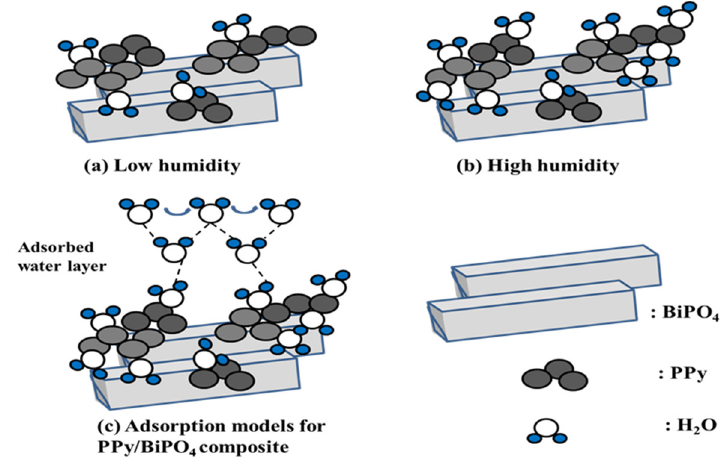
Figure 9. Scheme of humidity-sensing mechanism: ( a ) low humidity, ( b ) high humidity, ( c ) adsorption models for PPy/BiPO 4 composites.